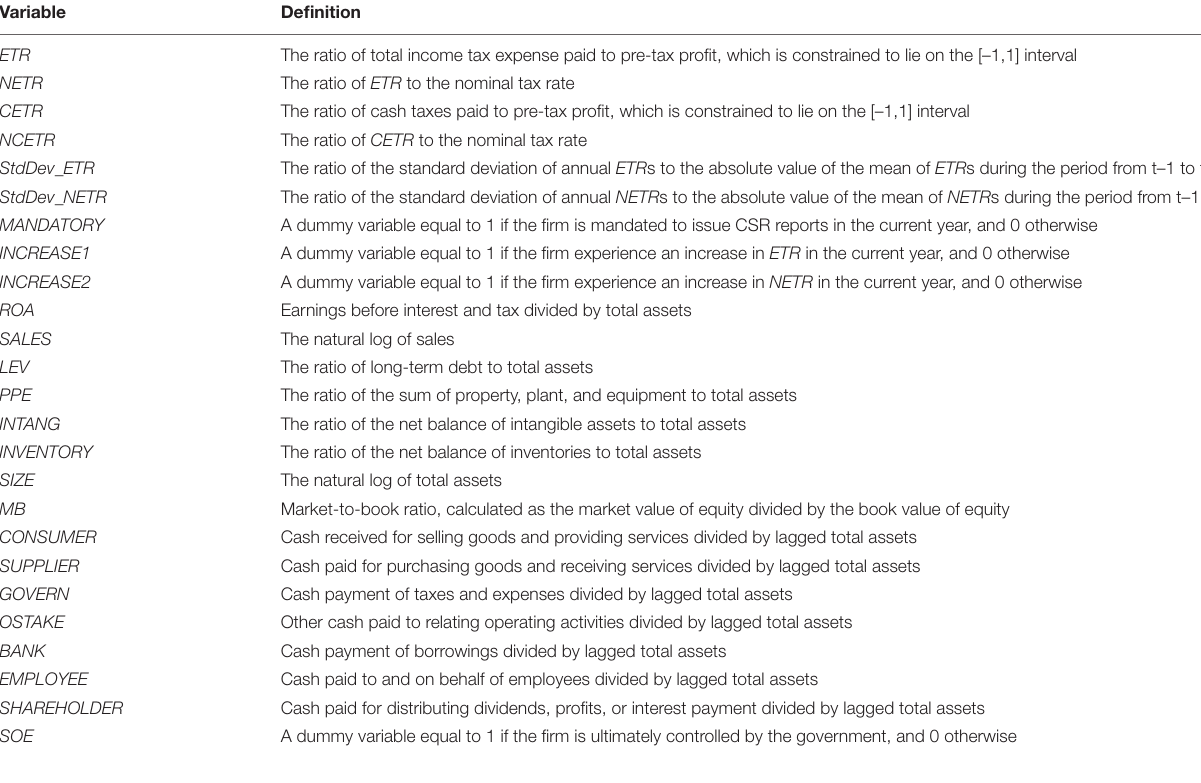
TABLE A1 | Variable